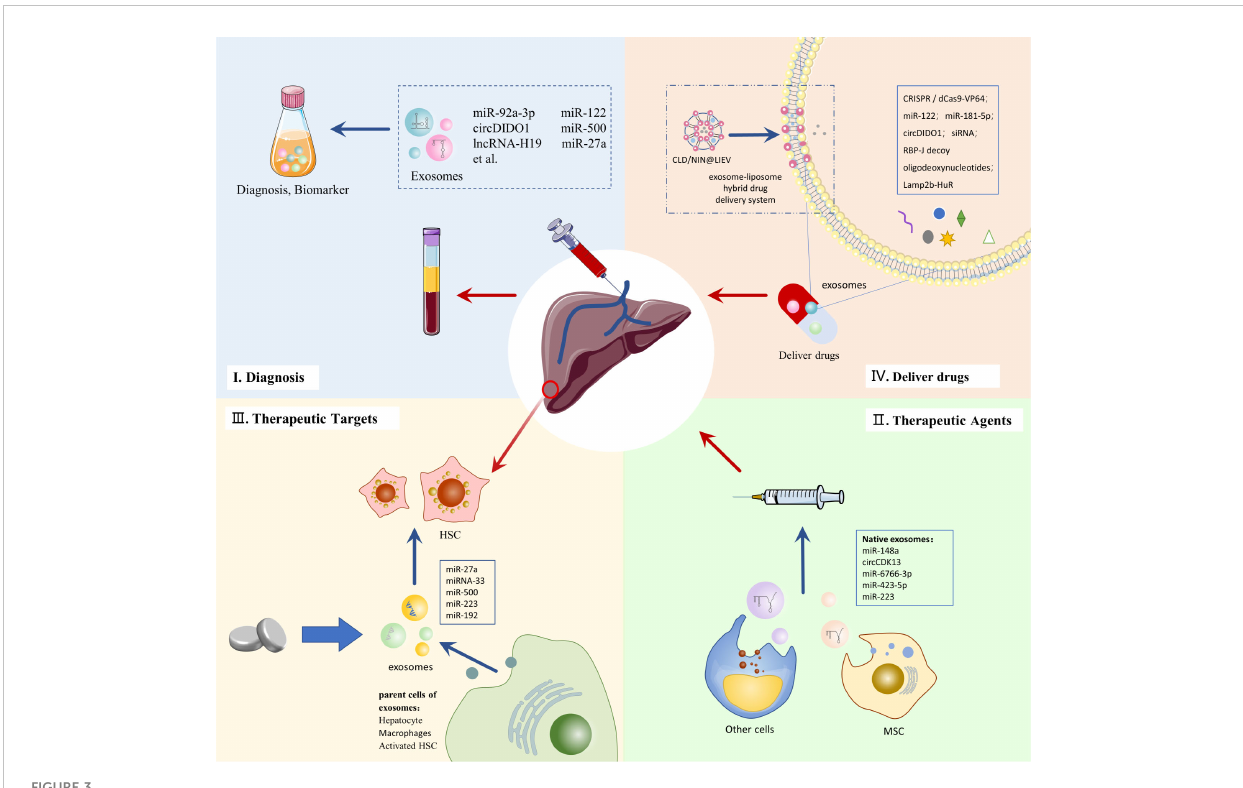
FIGURE 3 Clinical application of exosomes in